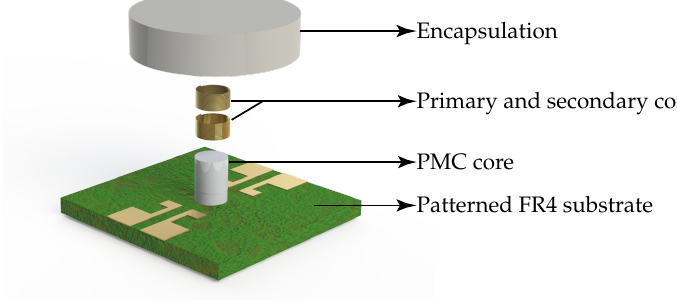
Figure 2. Exploded view of an encapsulated microtransformer